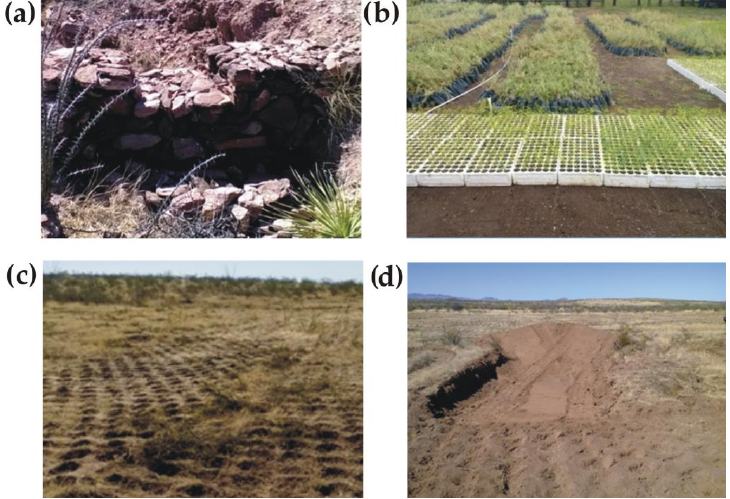
Figure A1. Examples of soil and water conservation practices implemented: ( a ) Gabion, ( b ) Native shrub spp. seedlings (i.e., Atriplex canescens and Prosopis glandulosa ), ( c ) Land imprinting, and ( d ) retention and infiltration pond.